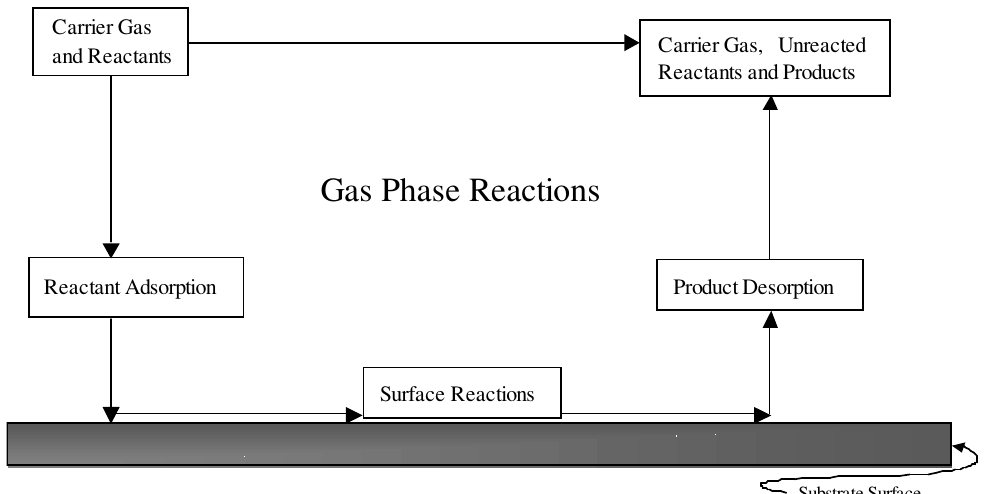
Figure 4. A basic outline of the CVD method, depositing a film on to the substrate surface. Figure adapted with permission from